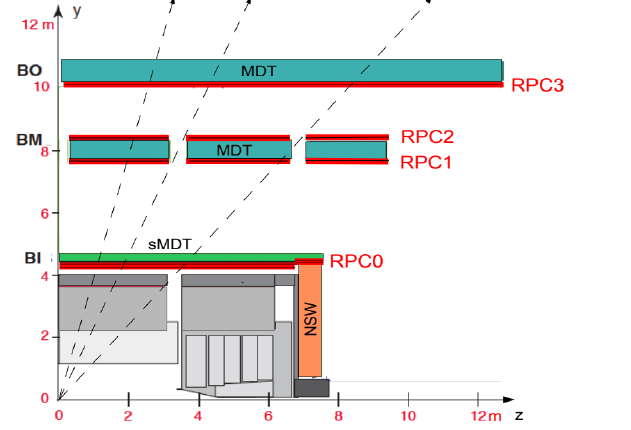
Figure 1. Sketch of a transverse section of the barrel region representing one of the sectors that contain a barrel toroid coil and its support structures. The four groups of RPC chambers (red) are shown as well as the MDT chambers (green and cyan) on the BI, BM, and BO stations. The three dashed lines represent muon trajectories traversing di ff erent combinations of RPC chambers